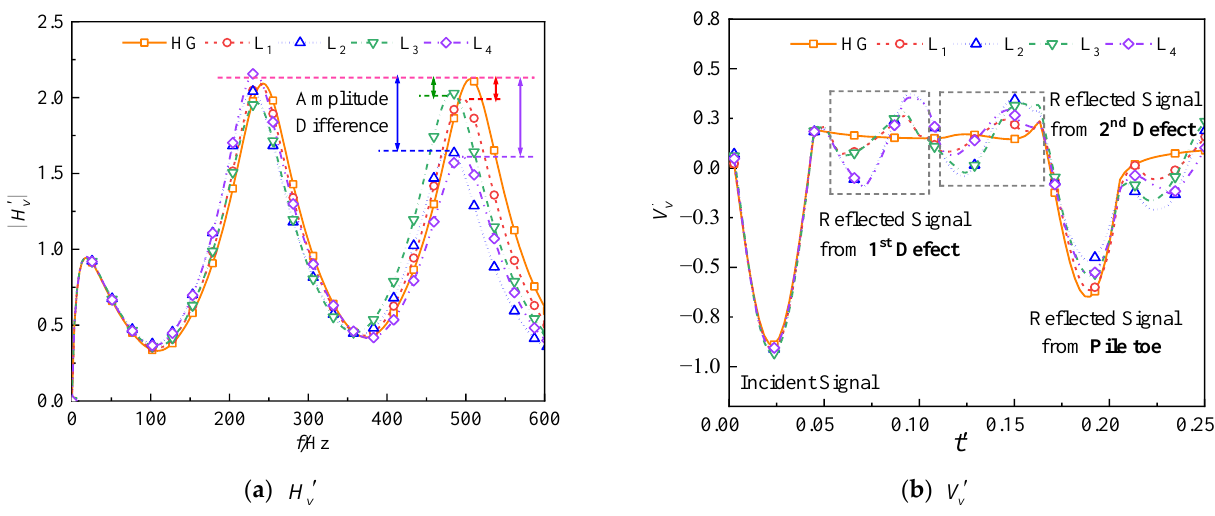
Figure 10. Effect of the length of necking defects on the pipe pile response. ( a )